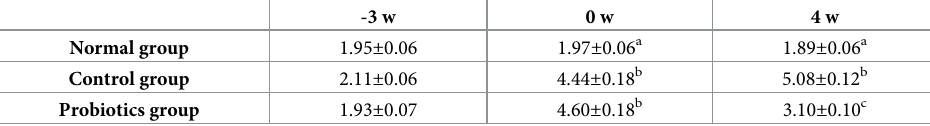
Table 8. The effect of probiotics treatment on plasma soluble CD14 concentrations ( μ g/mL) in adenine-induced CKD rats.